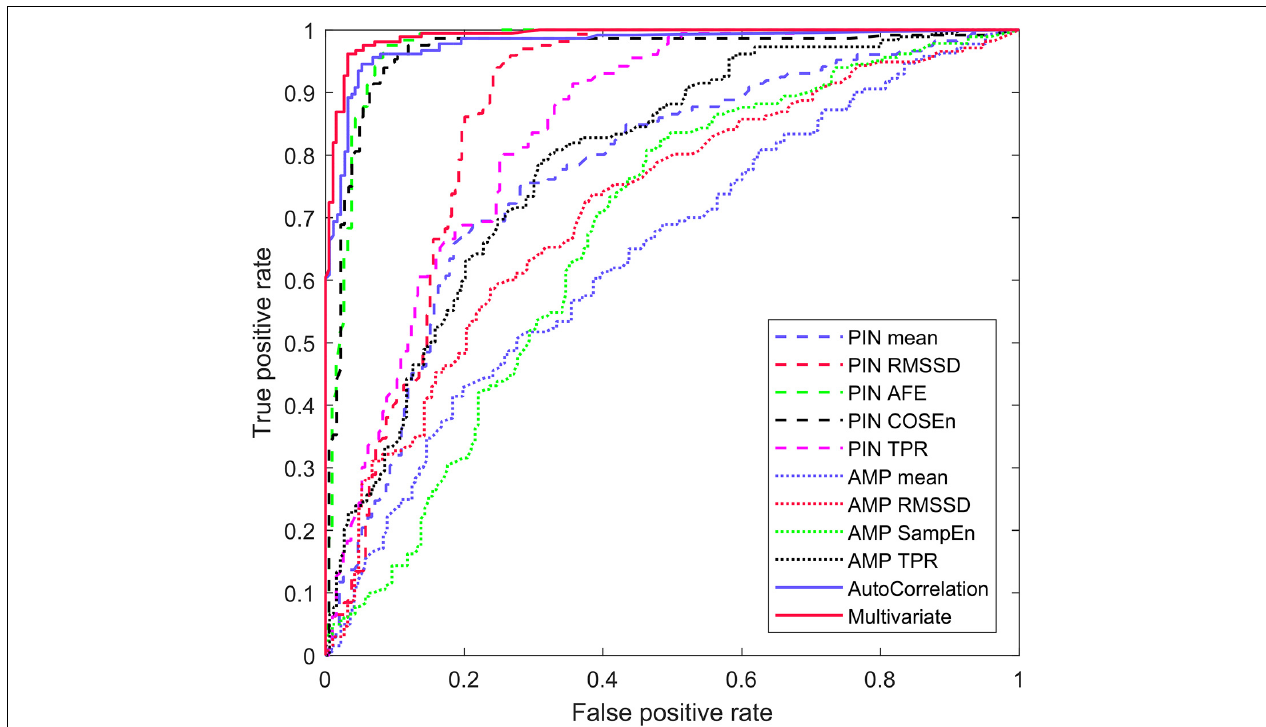
FIGURE 4 | Averaged AF detection ROC curve of the univariate models and the multivariate predictor